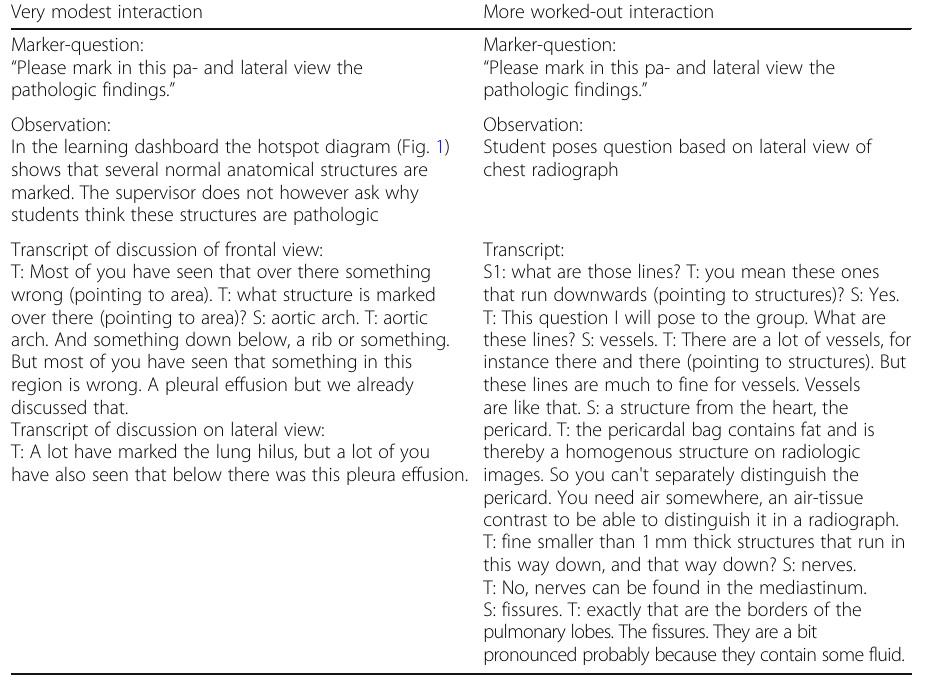
Table 3 Examples of verbal interactions during class-wide discussions on identifying salient findings in images Very modest interaction More worked-out interaction